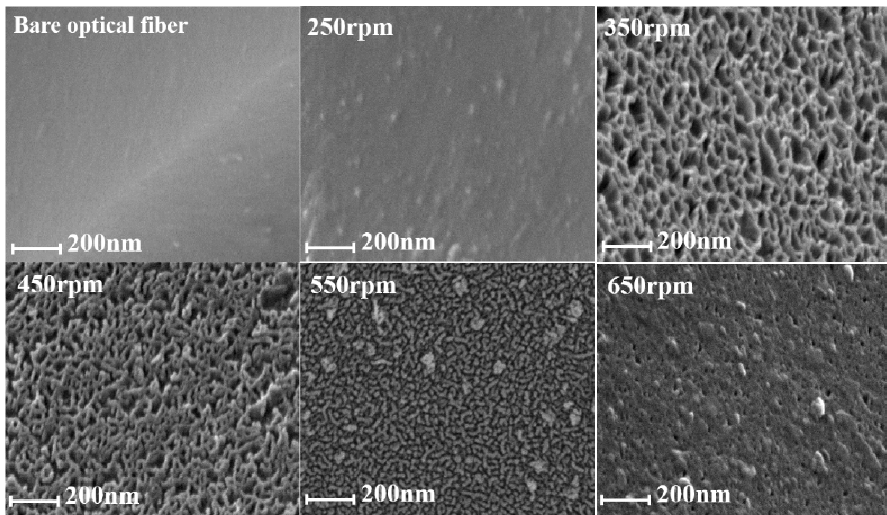
Figure 1. Scanning electron microscope (SEM) images of the surface of the bare optical fiber and porous-layer modified fiber with different magnetic stirring speed.